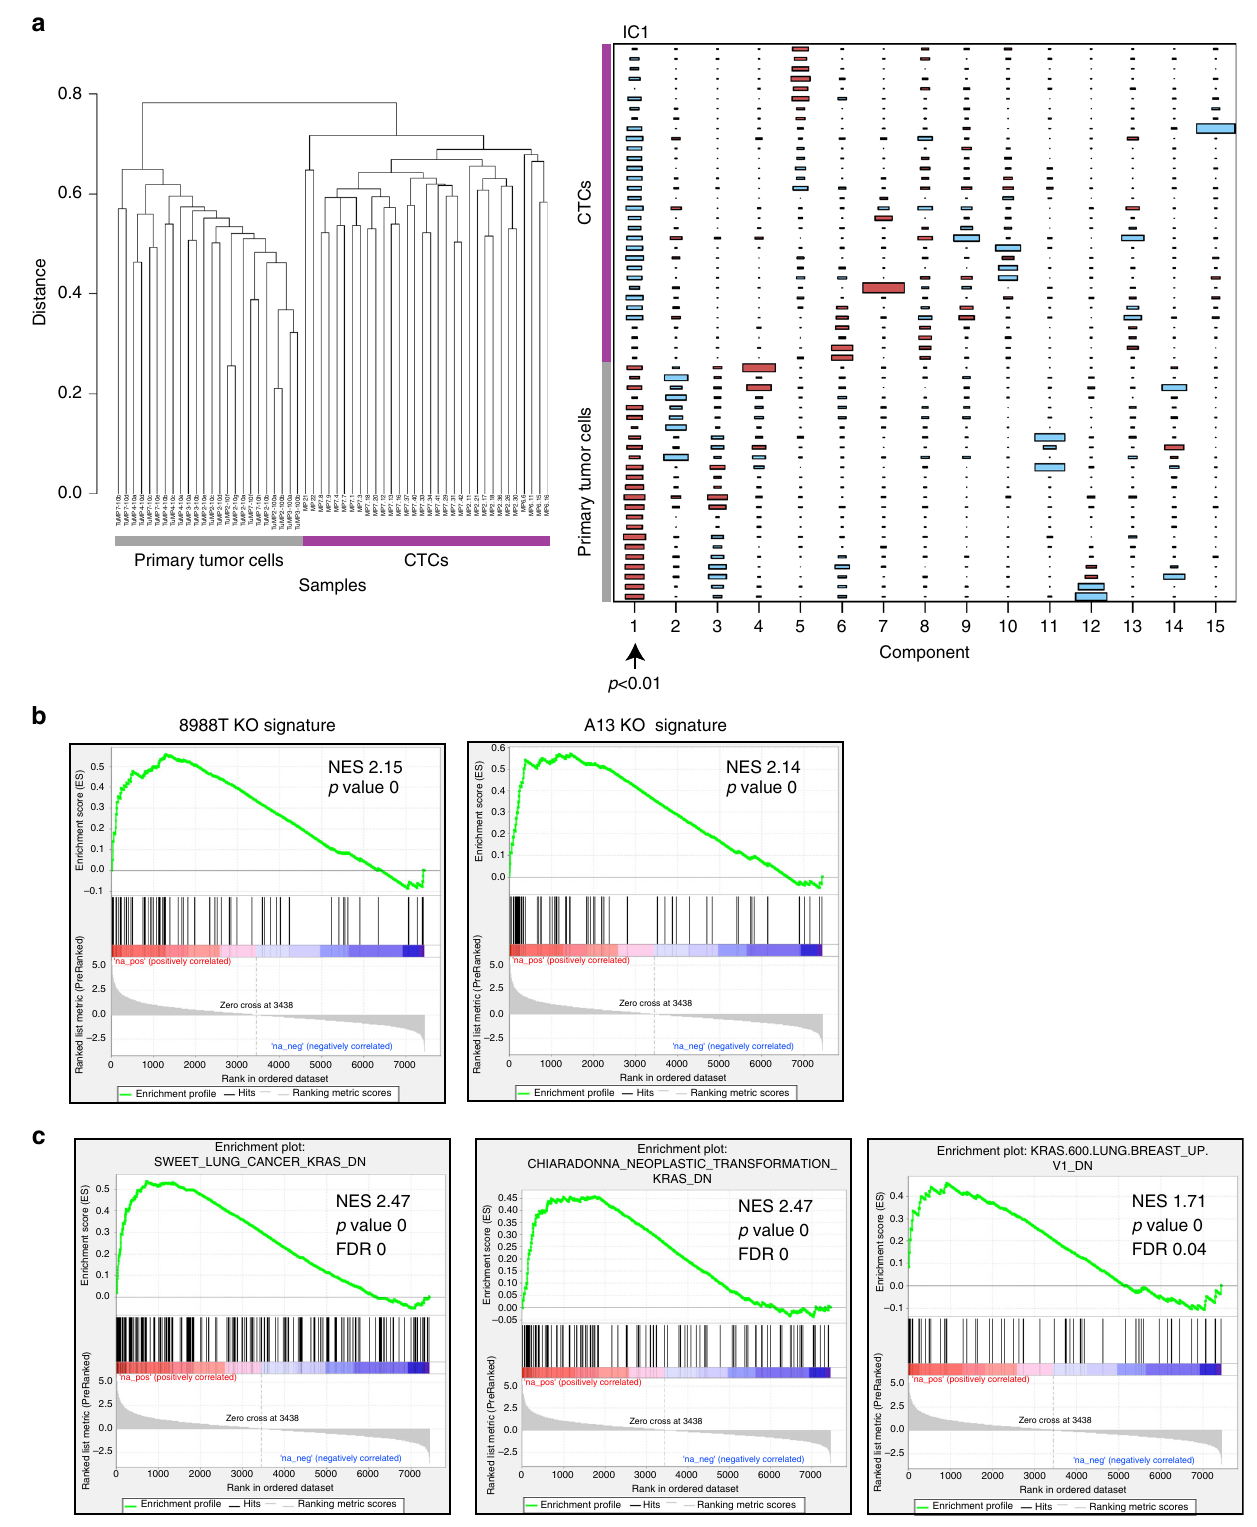
Fig. 9 KRAS knockout signatures correlate with CTC gene expression. a Unsupervised hierarchical clustering and ICA analysis of single cell RNA-Seq data from Ting et al. 44 using circulating tumor cells (CTCs) and primary tumor cells from a Kras;p53 mutant mouse model. ICA analysis identi fi ed a signature (component 1 (IC1) in Hinton diagram) that distinguished CTCs from primary tumors ( p < 0.01, Mann – Whitney U -test). b GSEA plots of 8988T and A13 knockout signatures (top/bottom 2% genes) enriched in ICA-derived CTC signature shown above. Normalized enrichment scores (NES) and p values are listed for each gene set. c Signi fi cantly enriched MSigDB gene sets in CTCs include genes downregulated (DN) following KRAS expression in the KrasLA2 lung cancer mouse model (Sweet), mouse fi broblasts (Chiaradonna), and in primary human lung and breast epithelial cells (KRAS.600). NES, p values, and FDR are listed for each gene